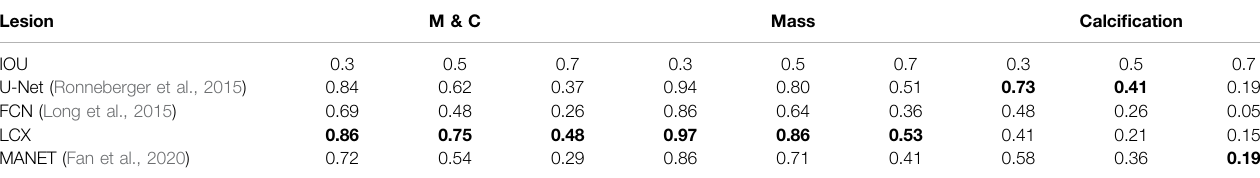
Bolded numbers indicate highest score obtained under each